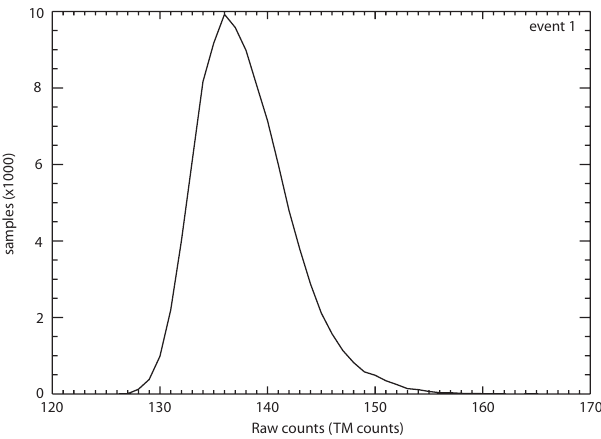
Fig. 6. Histogram of absolute value of the raw HF data, sampled twice per Langmuir wave period, at the peak values. The x-axis is the raw signal level in integer counts (0–255) and the y-axis displays the number of samples.